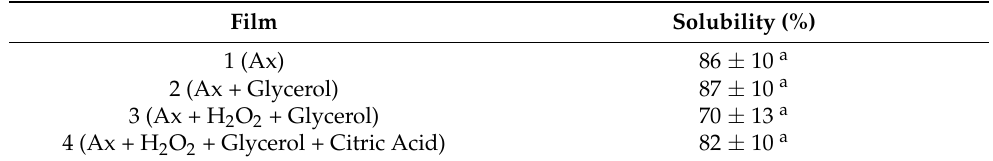
Table 4. Solubility in water (%) of arabinoxylan films obtained. Values in the same column followed by different superscript letters differ significantly ( p < 0.05).